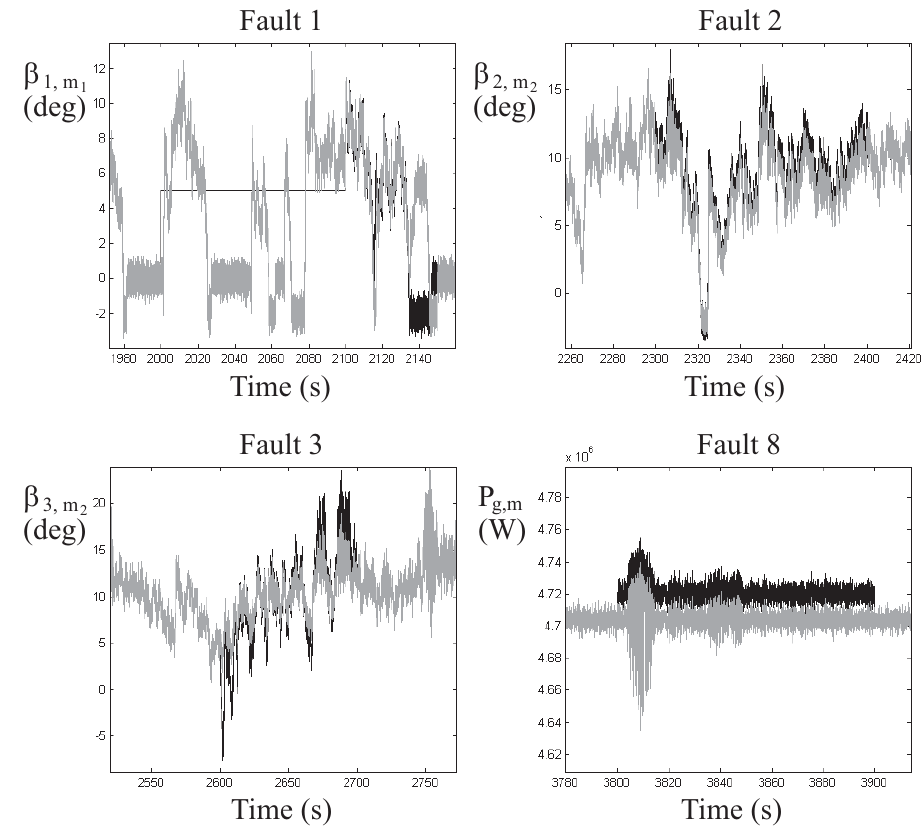
Figure 4. The fault-free (gray line) signals with respect to the faulty ones (black